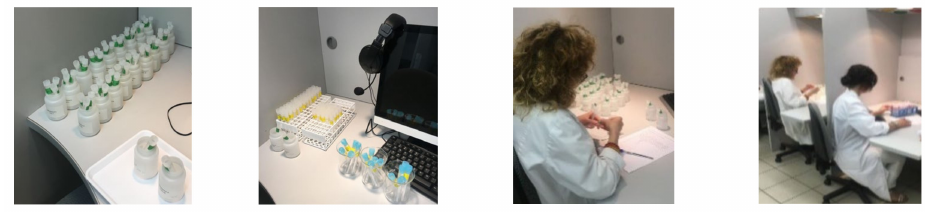
Figure 1. Training session related to boar taint detection by assessors participating in sensory